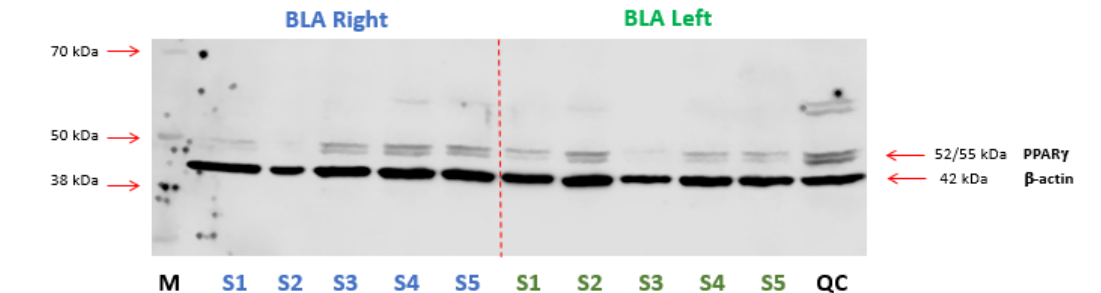
Figure 15. Expression of PPAR α , PPAR β / δ , and PPAR γ in the right and left BLA in four or five samples (S1–S4/S5 per side). The expression of PPAR α ( A ) as seen at 55 kDa, PPAR β / δ ( B ) at 52 kDa,